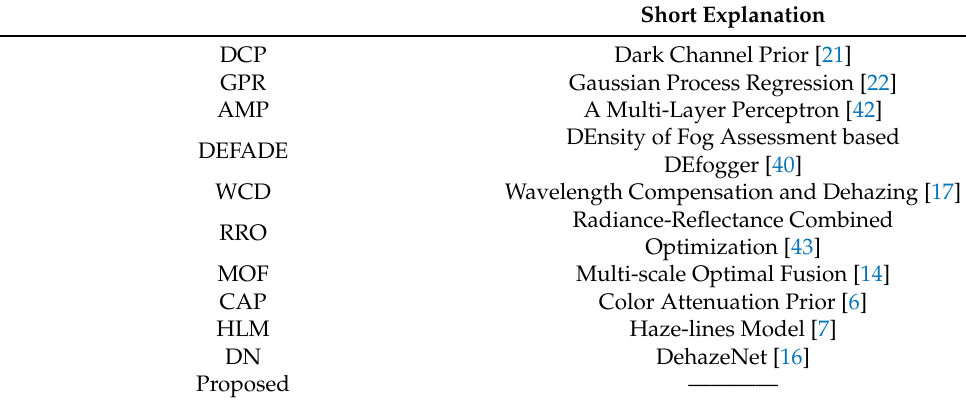
Table 1. Eleven remote sensing image dehazing methods for